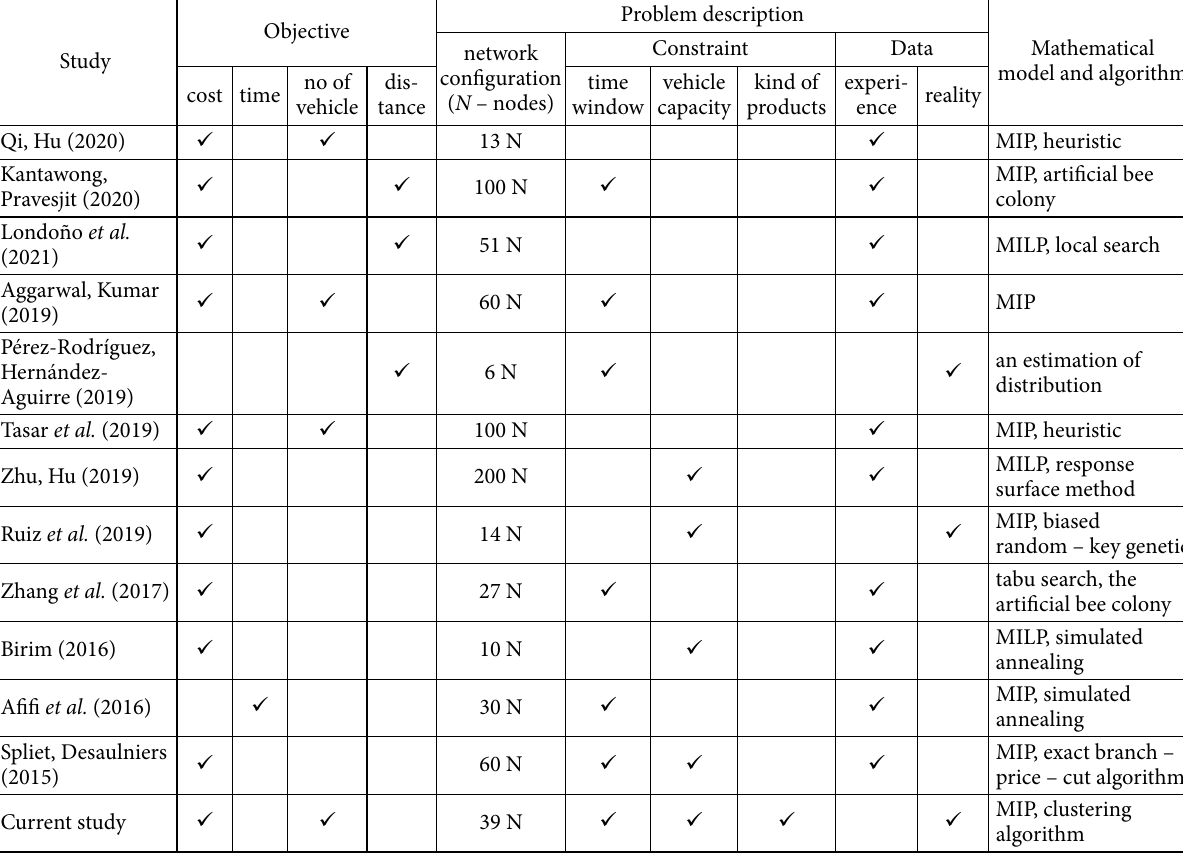
Table 1. VRPs of previous studies (source: current study)